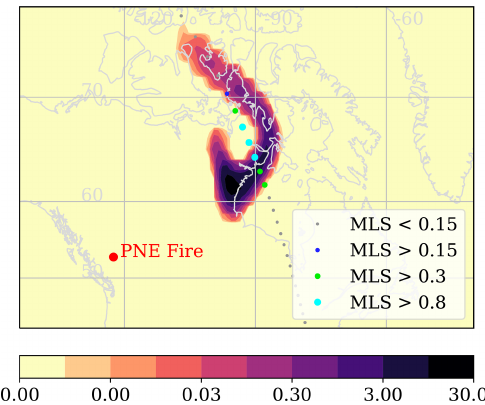
Figure 11. FLEXPART CO mixing ratio in parts per million by volume at an altitude of 12km on 15 August 2017 at 18:00. Dots show the location of MLS profiles from an orbit at a matching time. The dots are coloured to show where MLS CO, interpolated to an altitude of 12km, is below 0.15ppmv and where it exceeds 0.15, 0.3 and